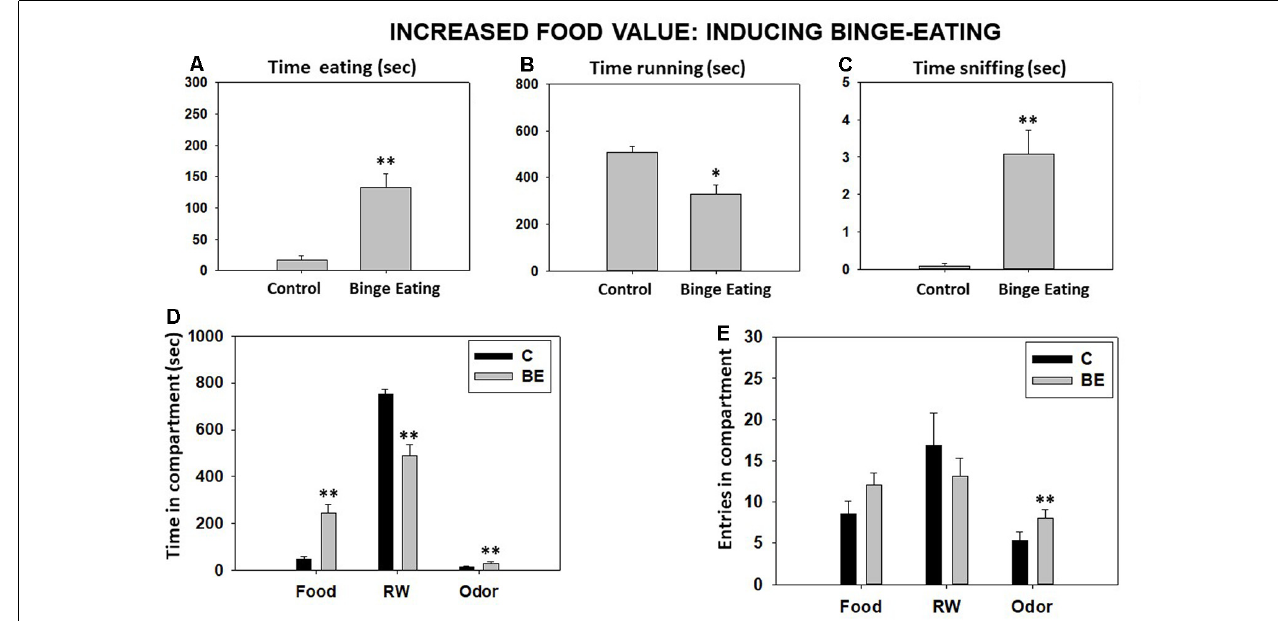
FIGURE 4 | Effect of binge eating pattern for sucrose pellets on time eating (A) , time running (B) , time sniffing (C) , time spent in each compartment (D) , and compartment entries (E) in the T-maze task assessed during 15 min. Bars represent mean ± SEM of accumulated seconds or number of entries. ∗ p < 0.05, ∗∗ p < 0.01 significantly different from the control group.